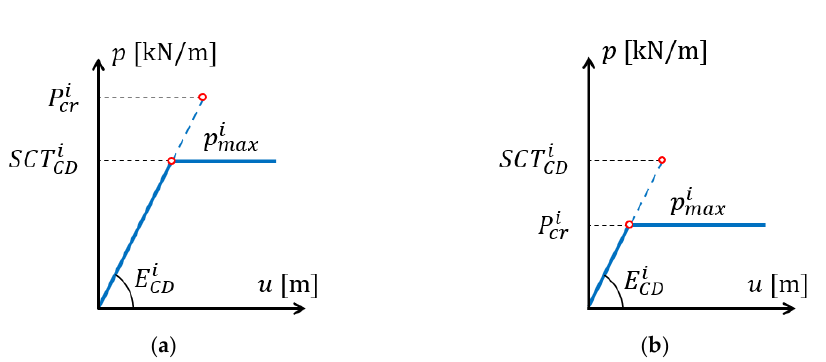
Figure 3. Maximum load of the 𝑖 -th layer: ( a ) case where the compressive strength occurs first; ( b ) case where the critical load occurs first.